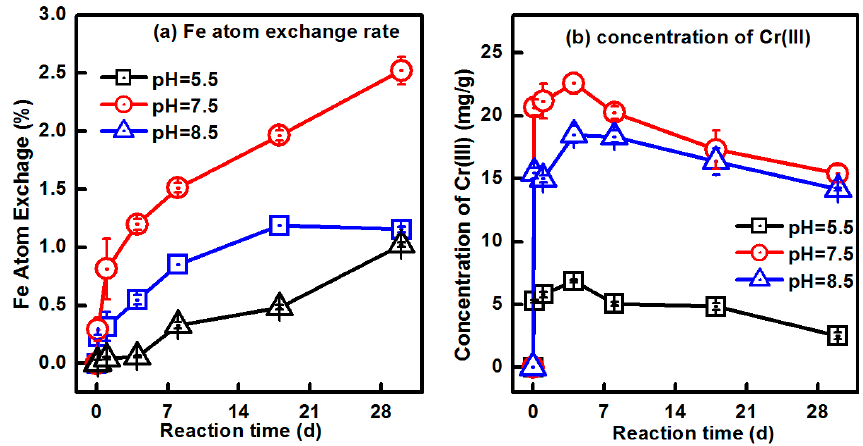
Figure 8. Changes in ( a ) Fe atom exchange percentage and ( b ) Cr(III) extr concentrations during the Fe(II) aq -induced recrystallization of 9.03% Cr-goethite over 30 days under various pH (5.5, 7.5, and 8.5) conditions.